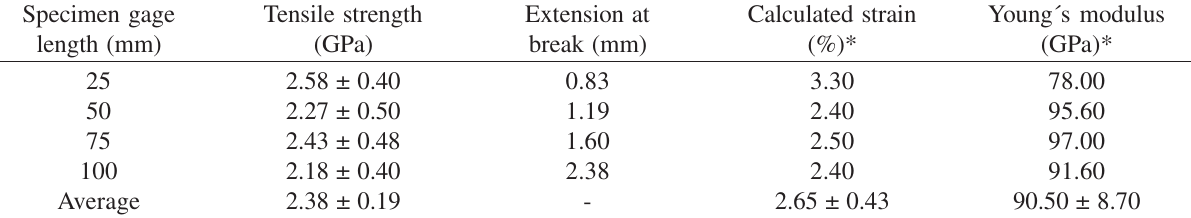
Table 2. Properties of glass fibres at various specimen gage length.